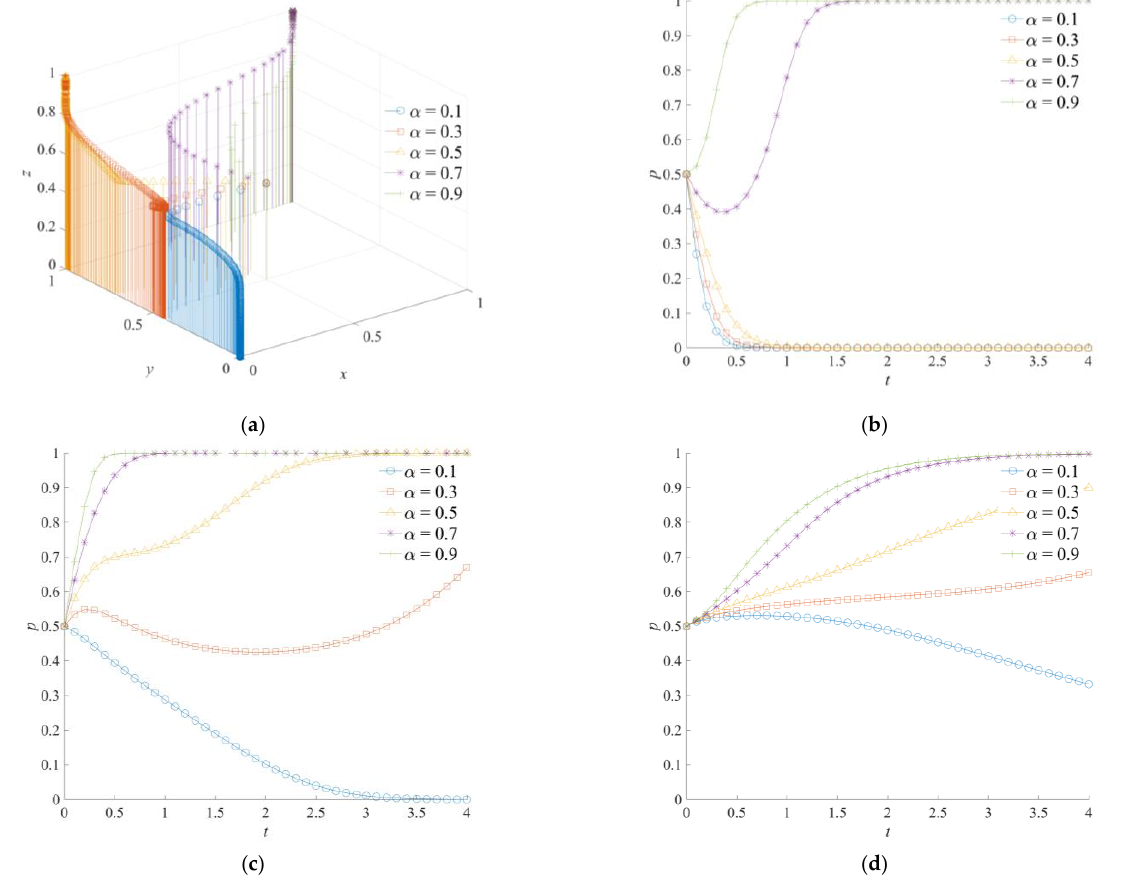
Figure 6. Evolution trajectory of the game system under different efficiency coefficients of emergency rescue cooperation: ( a ) The influence of α on the evolution of the game system; ( b ) the influence of α on the evolution of the local government; ( c ) the influence of α on the evolution of the neighboring government; ( d ) the influence of α on the evolution of the central government.